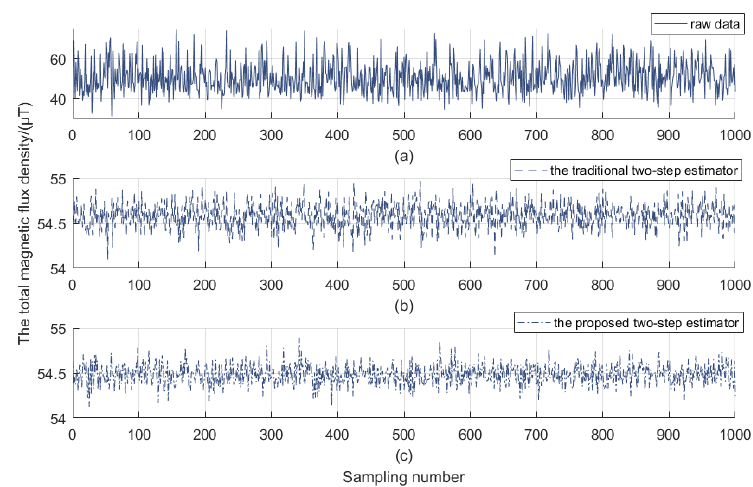
Figure 3. Total magnetic flux density before and after correction. ( a ) the error with raw data; ( b ) the